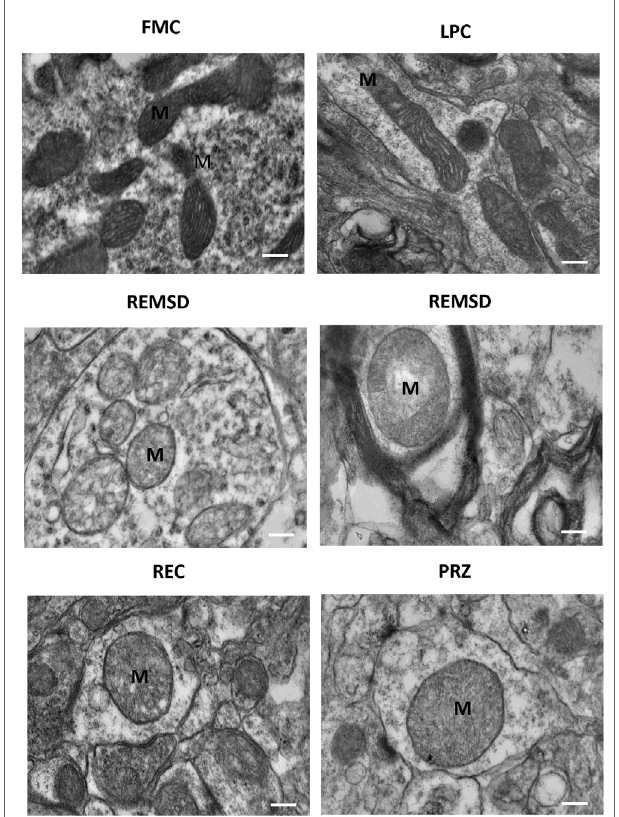
FigUre 12 | electron photo-micrograph (10,000 × ) showing mitochondrial ultrastructural changes in lc neurons of rats treated under various conditions . Normal elongated mitochondria can be seen in neurons from FMC and LPC rat brains. Images of two different rat brains after REMSD are shown as compared to one each from other control rat brains. Mitochondria appeared swollen with cristae disintegrated or reduced with transparent matrix in the REMSD rat brains. Cristae appeared less distorted in REC rat brain. In PRZ-treated group, although swelling appeared, the inner cristae of mitochondria appeared intact. M – mitochondria; scale bar: 100 nm.